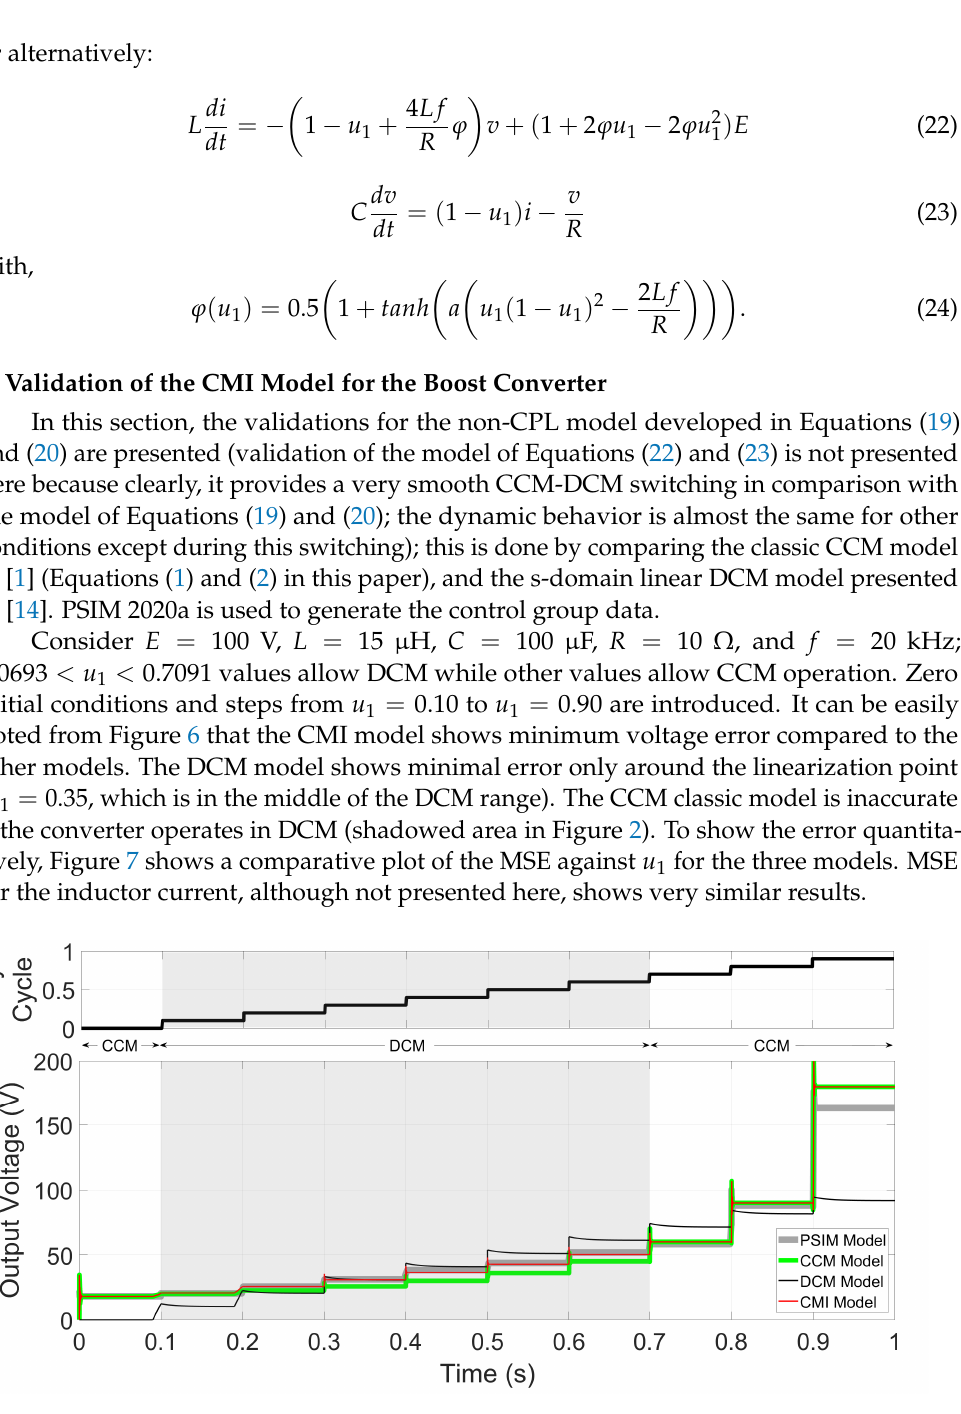
Figure 6. Comparative of the output voltage for PSIM (averaged), CCM, DCM, and CMI models, using steps from u 1 = 0.0 to u 1 =